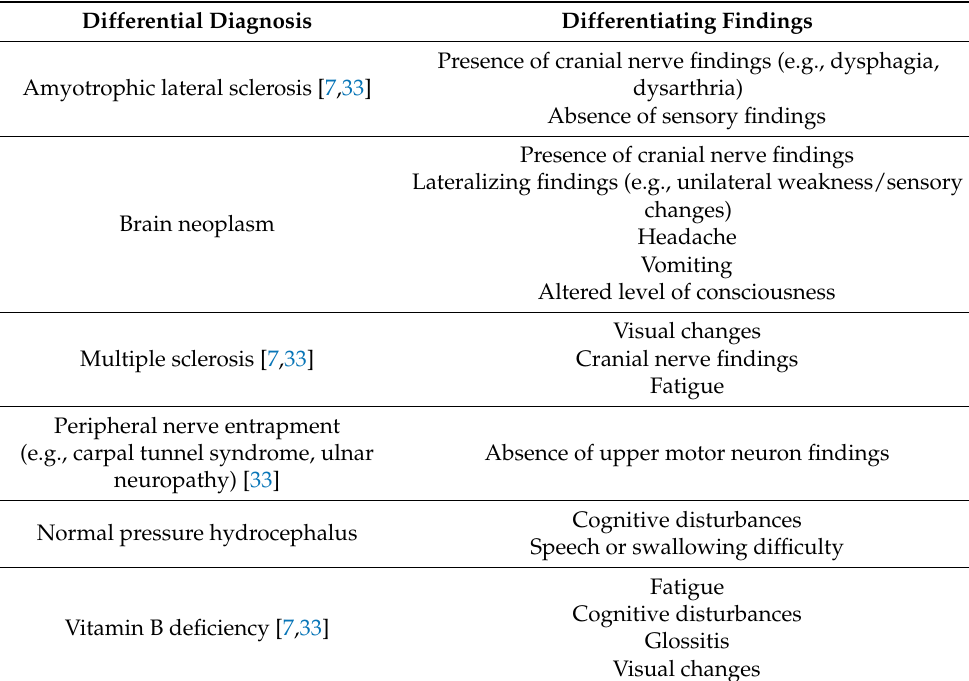
Table 2. Approach to differential diagnoses of